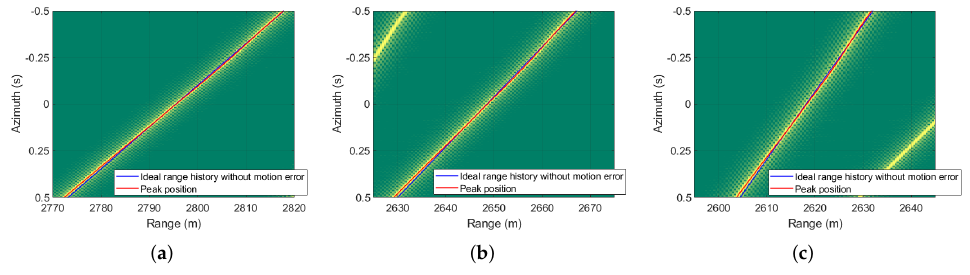
Figure 7. Azimuth signal extraction: ( a ) point A; ( b ) point B; ( c ) point C.